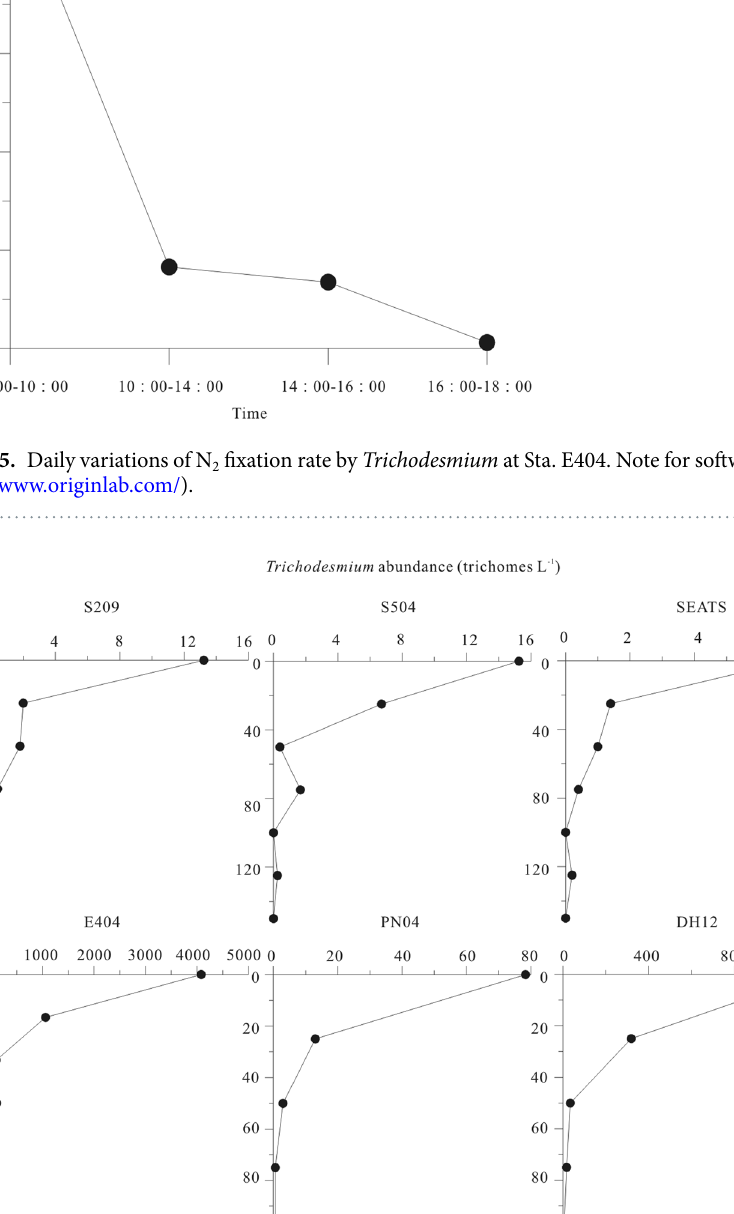
activity at most stations in the survey time. N 2 fixation was converted to carbon production using the Redfield ratio (C:N = 6.6:1) for comparison with the primary production. N 2 fixation by the whole-water was calculated